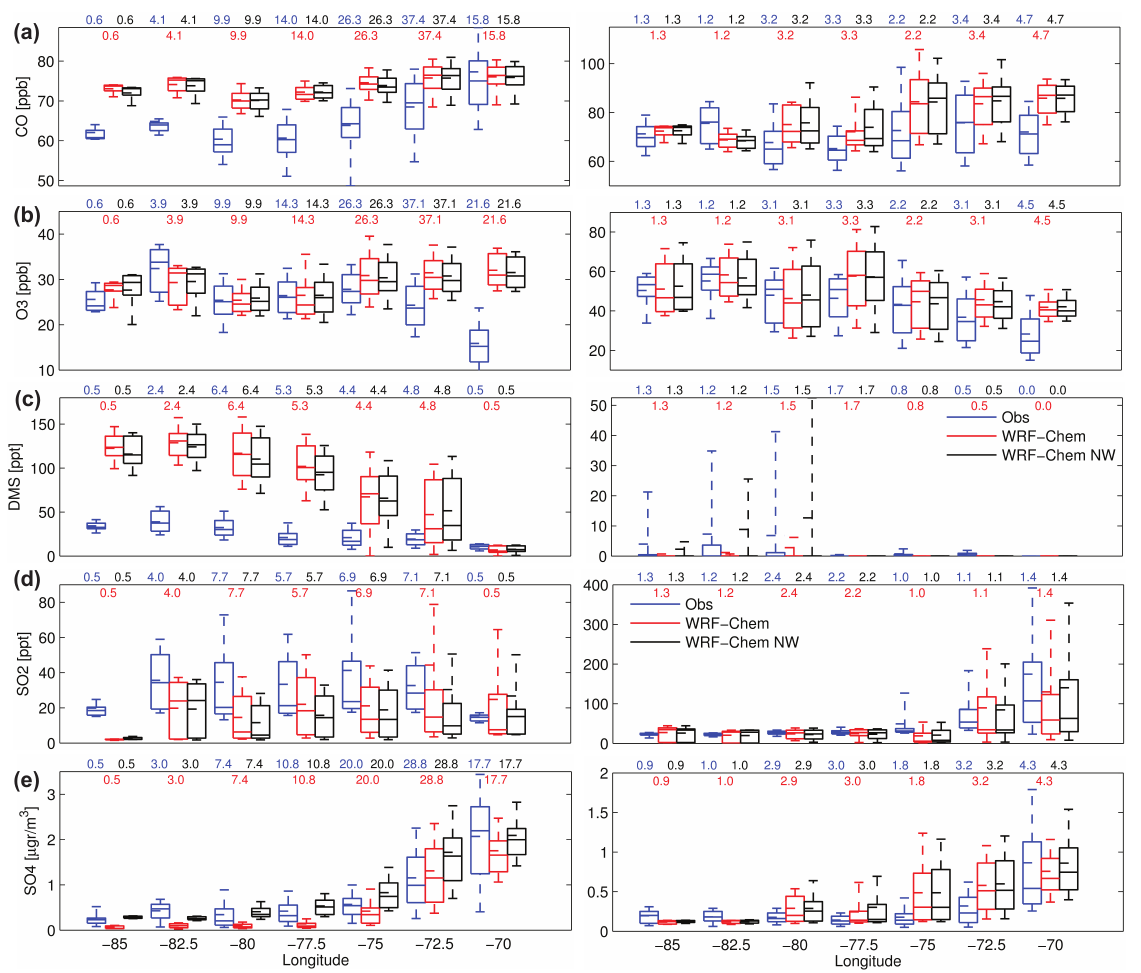
Fig. 1. Observed and modeled statistic for selected gaseous and aerosol species gridded into 2.5 degree longitudinal zones in between 22 ◦ S and 18 ◦ S. For each zone, centre solid (dashed) lines indicate the median (mean), boxes indicate upper and lower quartiles with upper and lower decile whiskers. The sampling time in decimal hours in each longitude bin is indicated at the top. Left column and right column are for marine boundary layer (MBL) and free troposphere (FT),